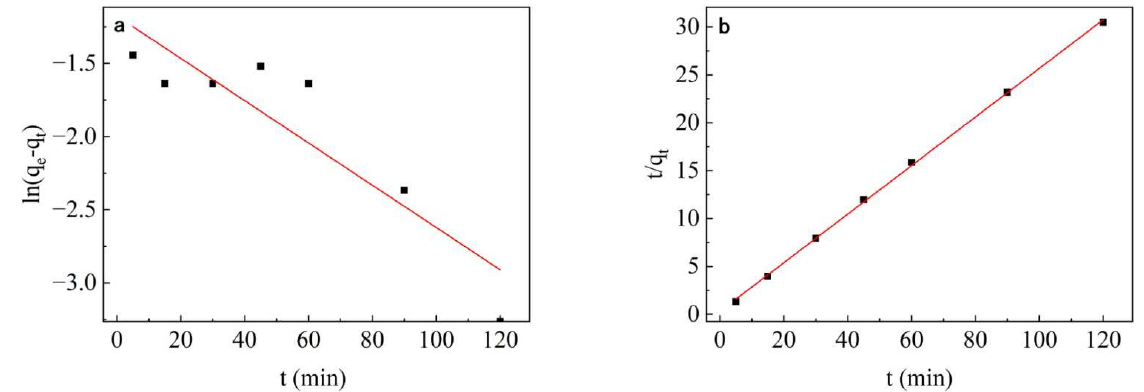
Figure 7. ( a ) Immobilized dextranase reusability assay. ( b ) Immobilized dextranase storage assay. On the bar chart, the different lowercase letters show that there are significant difference ( p > 0.05).